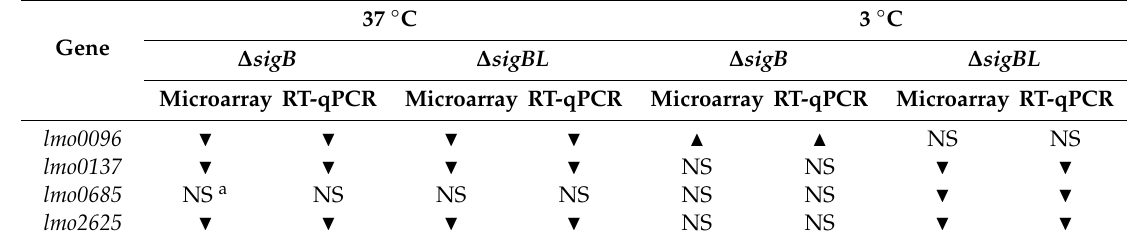
Table 2. Validation of selected DNA-microarray results with real-time RT-qPCR.